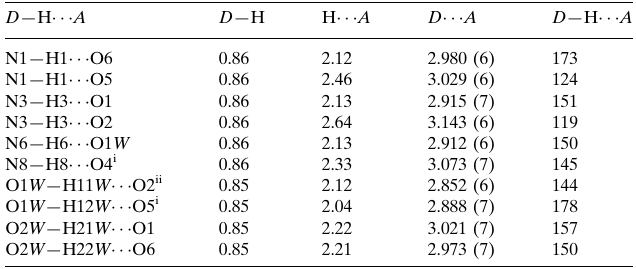
Hydrogen-bond geometry (A˚ , (cid:2)